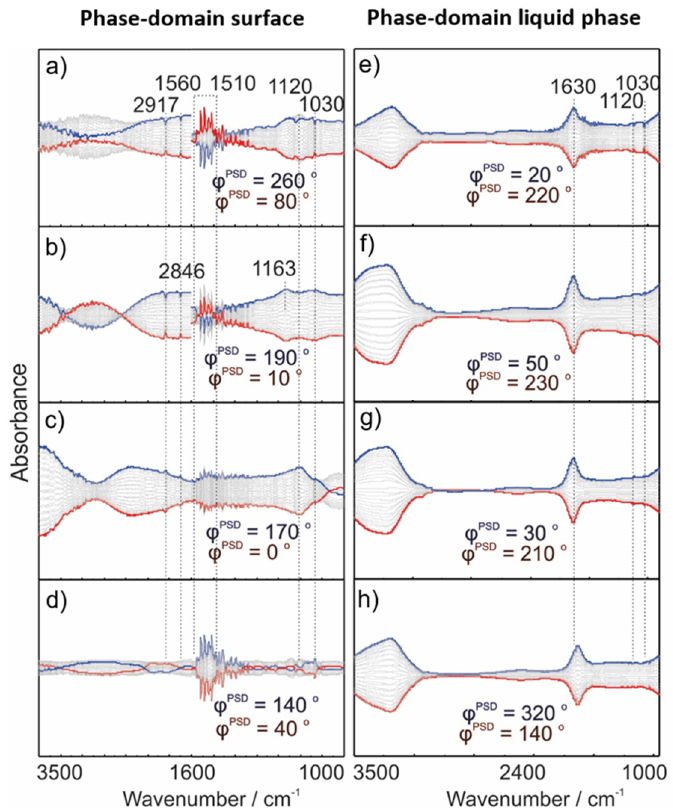
Figure 8. MES-ATR-IR spectra of ( a , e ) Au-Fe(1:2)/TiO 2 , ( b,f ) Au-Fe(1:1)/TiO 2 , ( c , g ) Au-Fe(1:0.5)/TiO 2 and ( d , h ) Au/TiO 2 , obtained during Orange II + O 2 + UV ↔ Orange II + He + UV modulation.